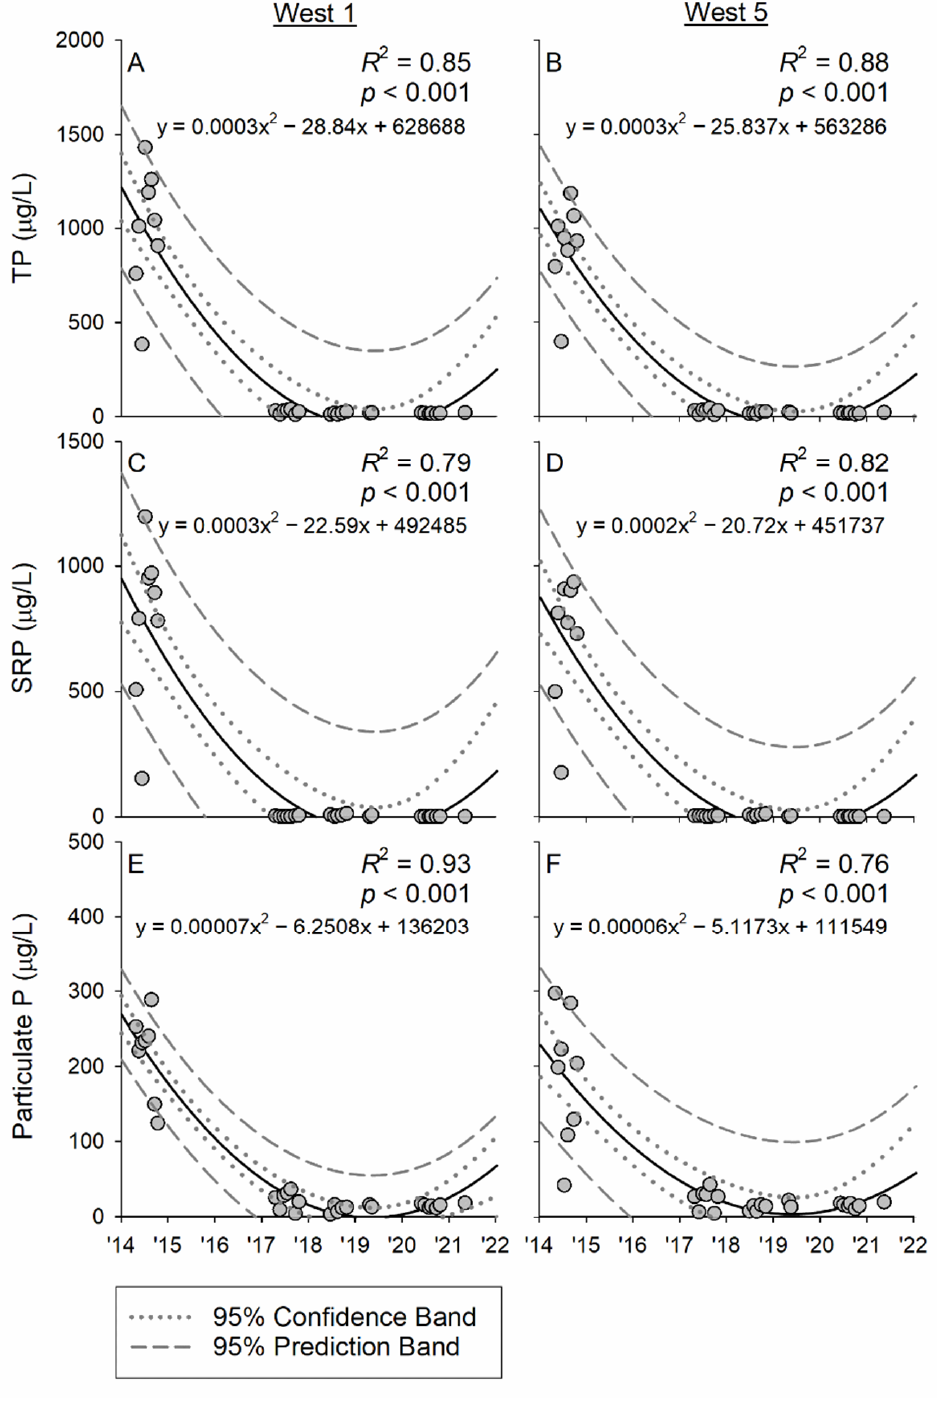
Figure 4. West pond phosphorus regressions of TP ( A , B ), SRP ( C , D ), and particulate P ( E , F ) at sites West 1 ( A , C , E ) and West 5 ( B , D , F ). Legend below E applies to all panels.